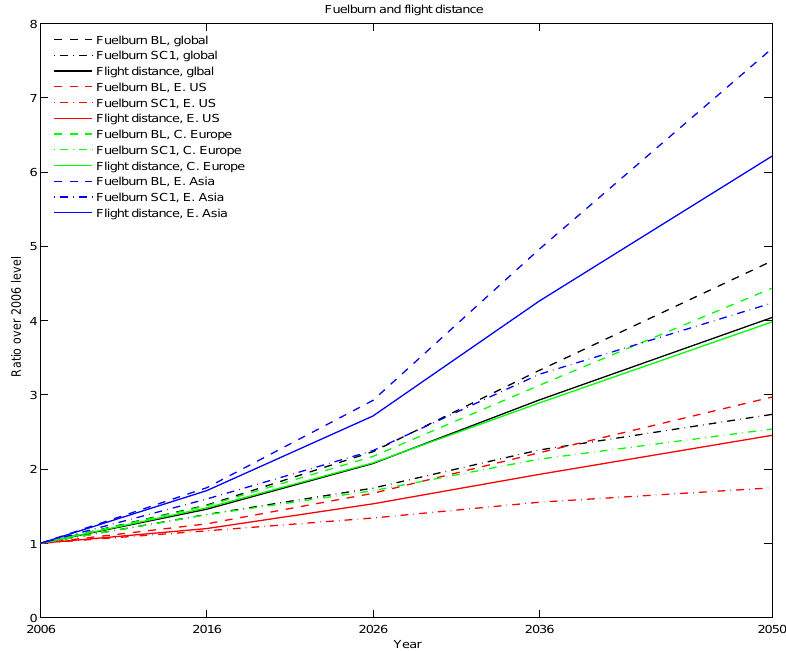
Figure 1. Global and regional flight distance and fuel burn under two future scenarios, baseline and scenario 1, over the 2006 level. The regions over eastern USA, Central Europe and East Asia are depicted by the blue boxes in Fig.